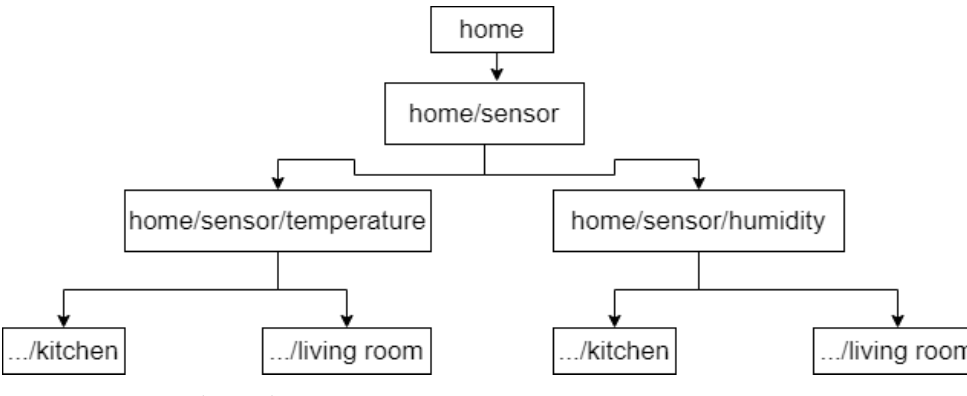
Figure 3. Topic tree